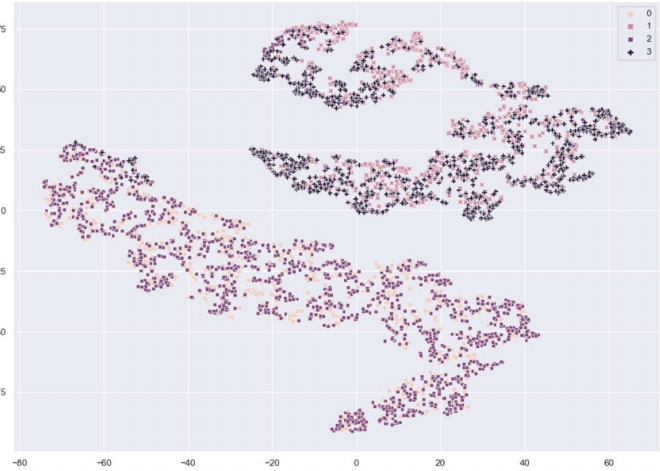
Figure 7. The distribution of fingerprint samples before adaptation within the same sensor. 0: train live, 1: train fake, 2: test live, 3: test fake samples from Crossmatch